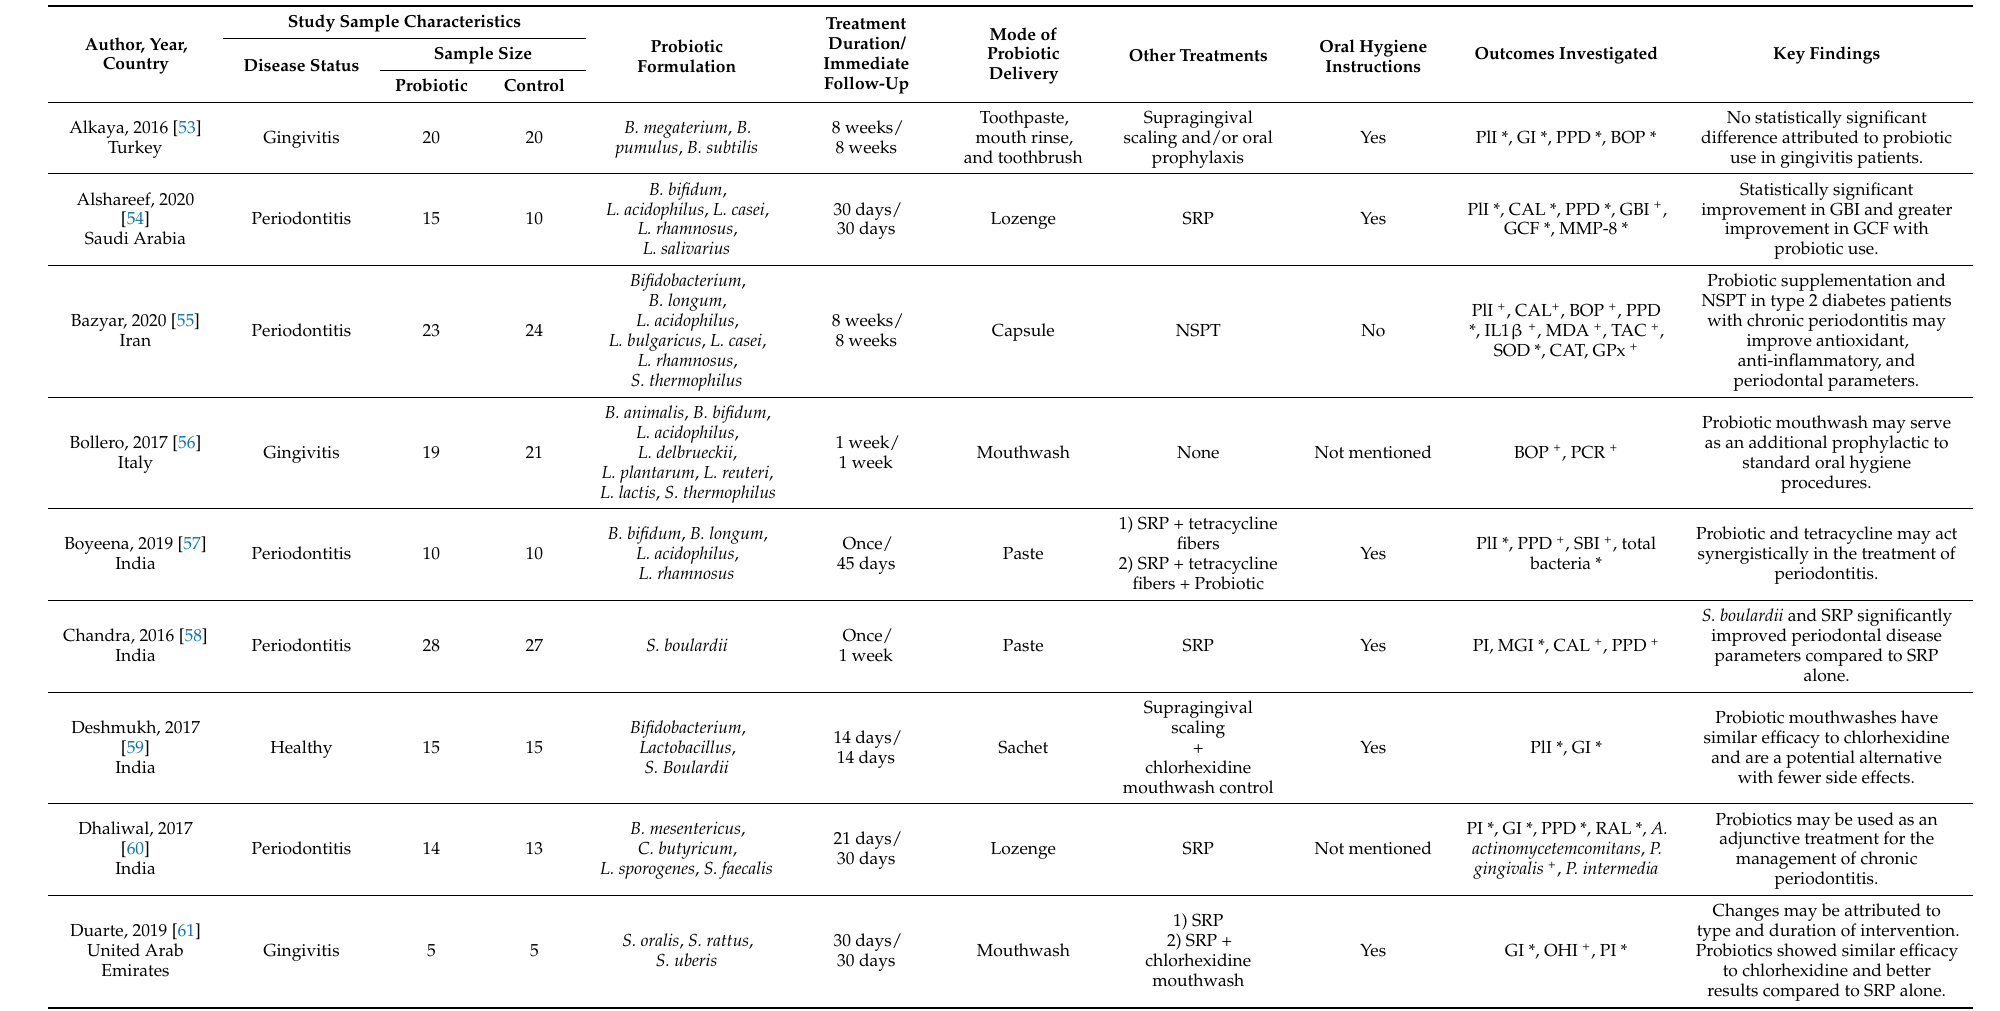
Table 1. Characteristics of the studies included in the systematic review and